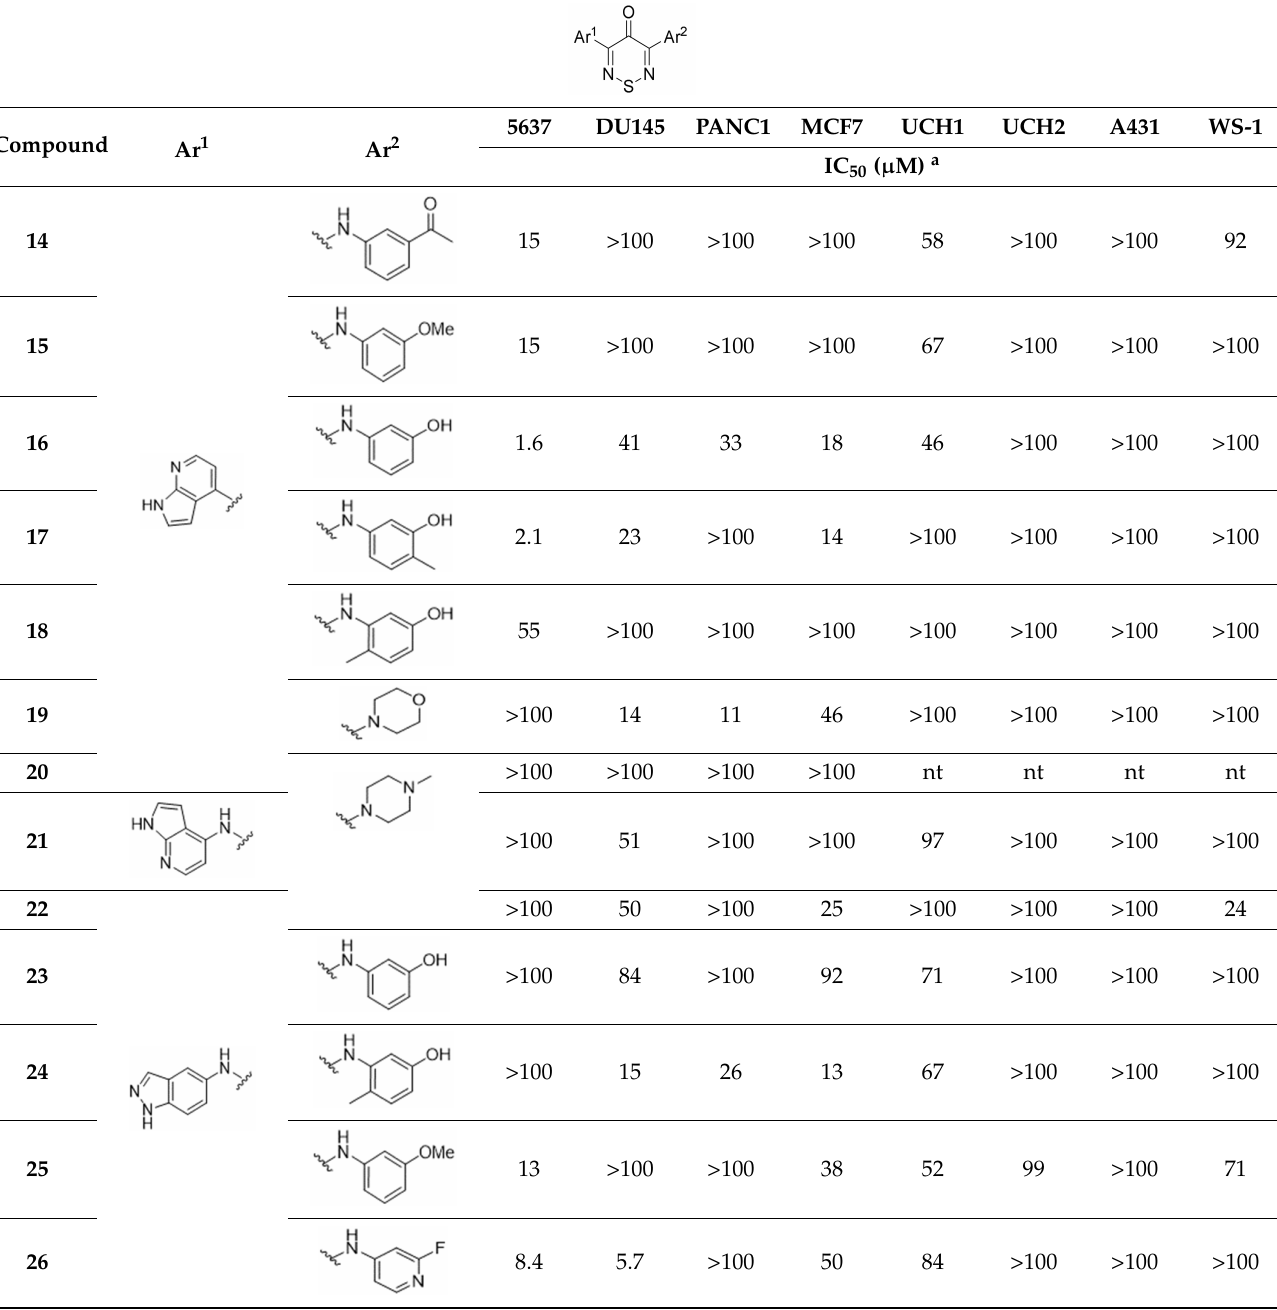
Table 1. Activity of anilinothiadiazinones on a panel of seven cancer cell